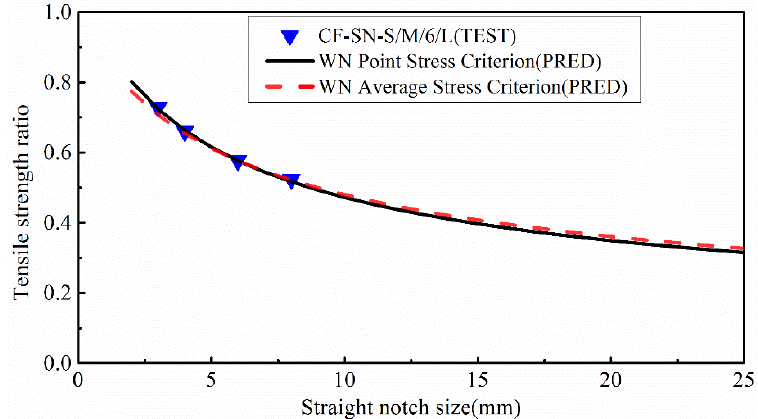
Figure 22. Comparison of the tensile strength ratio curves of the equal 𝑊 /2 𝐶 ratio group predicted by the point stress criterion and average stress criterion in the WN stress criteria with test results; it meets the curve of the test results well.